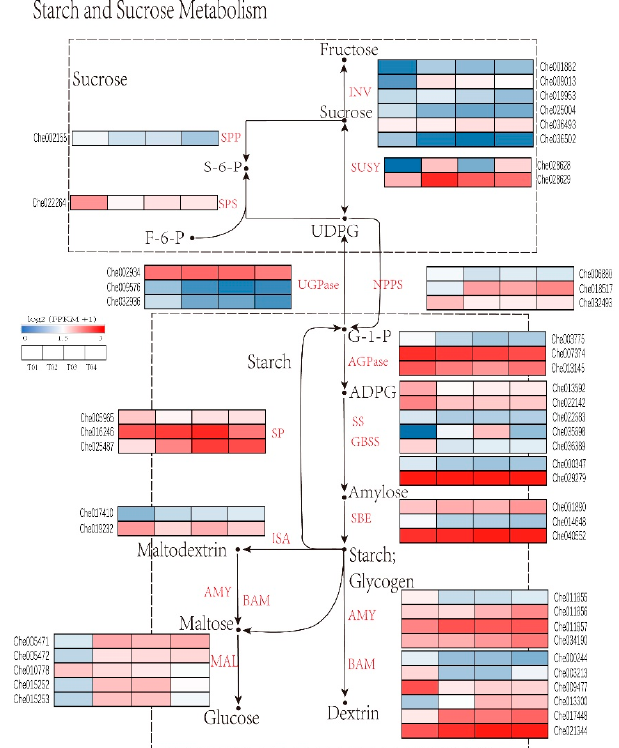
Figure 5. Volcano plots of the transcriptome between T01 and T02 ( A ), T01 and T03 ( B ), T01 and T04 ( C ), T02 and T03 ( D ), T02 and T04 ( E ), and T03 and T04 ( F ). The statistical significance (log10 of p -value; Y-axis) was plotted against log2-fold change (X-axis). The center of the volcano represents a fold change of zero, while the sides indicate downregulation (negative values) and upregulation (positive values).